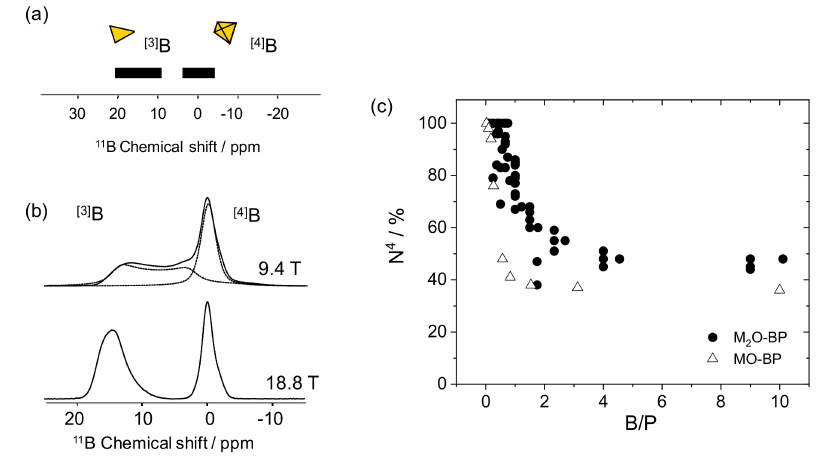
Figure 3. ( a ) Chemical shift ranges corresponding to the [3] B and [4] B speciation. ( b ) 11 B-MAS-NMR analysis performed on a sodium boro-phosphate glass at 9.4 and 18.8 T. ( c ) Compilation of N 4 values observed in di ff erent mono- (full circles) and di- (empty triangles) valent ions containing borophosphate glasses [19–24,28,29,31,32,34–36] versus the glass composition expressed here with the B 2 O 3 / P 2 O 5 ratio (B / P)